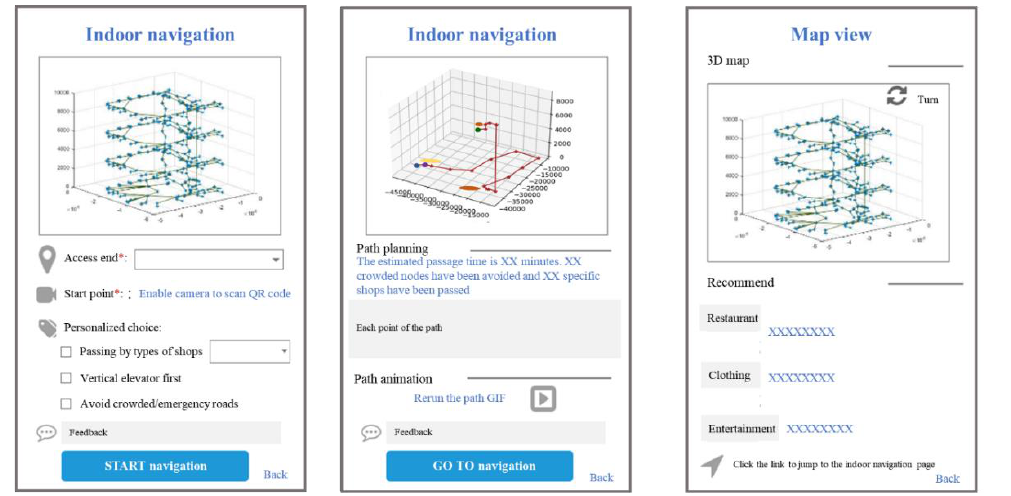
Figure 20. Shopping mall indoor navigation system function page.